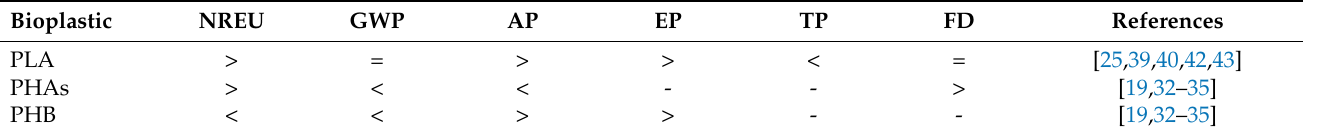
Table 3. Summary of bioplastics’ environmental impact potential compared to petroleum-based